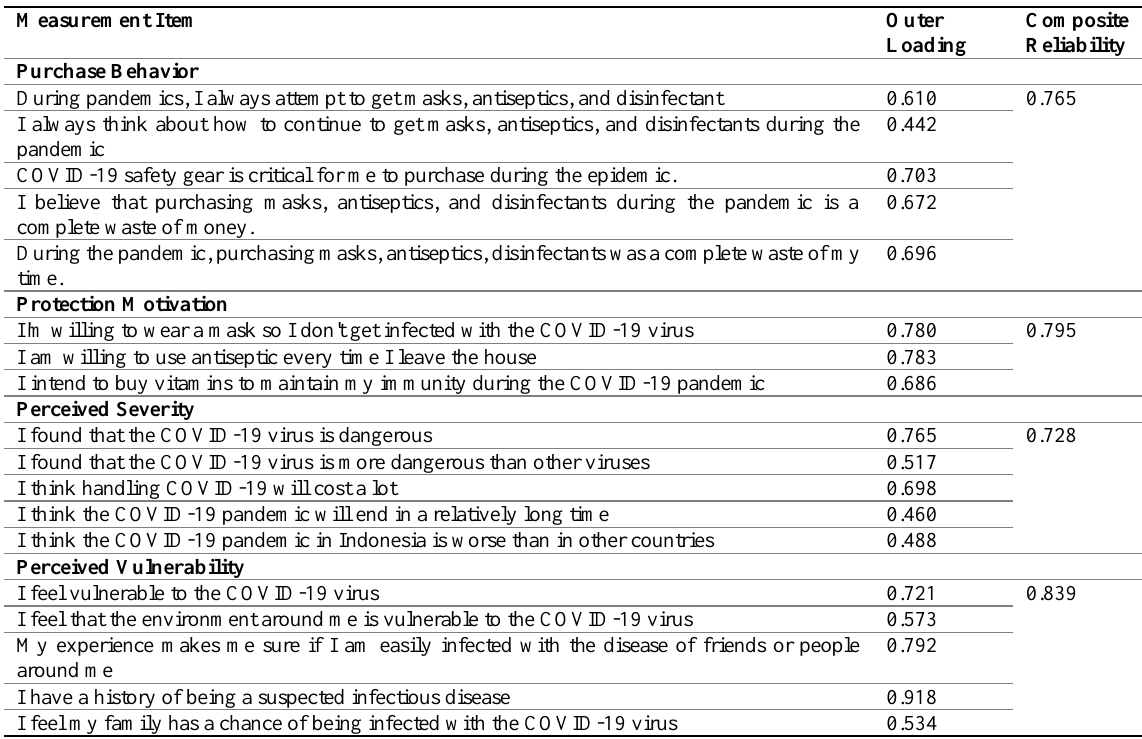
Table 1: Evaluation Results of Internal Consistency (Reliability) and Convergent Validity